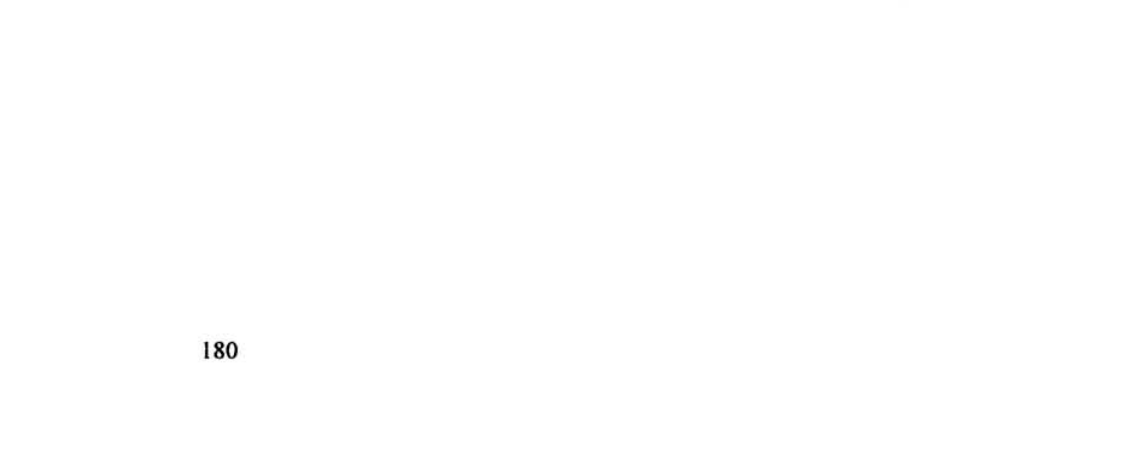
Fig. 16: Parchment samples' appearance after artificial aging process. Changes in the surface structure after treatment were observed using optical microscopy (Figure 17). The initial sample has a hierarchical fibril structure of the surface. After the treatment the structure was completely destroyed. This analysis can serve as a non-destructive tool for rapid detection of surface morphological changes during the artificially ageing process and for investigation of historical samples. To characterize more detailed changes in the degree of deterioration after a complete cycle of the artificial ageing, modern and aged parchments used in two artificial aging cycles (number 1-4 and 35-38) were examined using scanning electron microscopy (SEM) (Hitachi S-4000, Hitachi Inc, Japan) from both sides. Microphotographs of the parchment surfaces were taken at three scales: 200 μηι, 50 μιη, and 10 μηι (Figure 18). The samples examined covered a wide range of surface types, thicknesses and animal skin